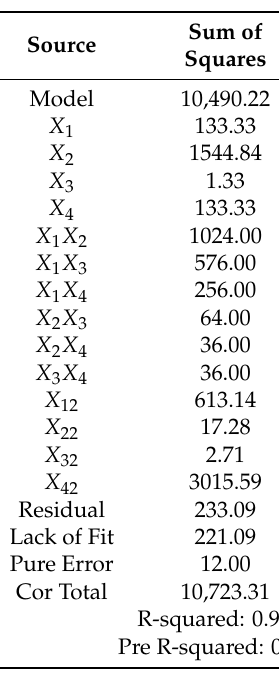
Table 7. ANOVA of apple-picking equipment quadratic model